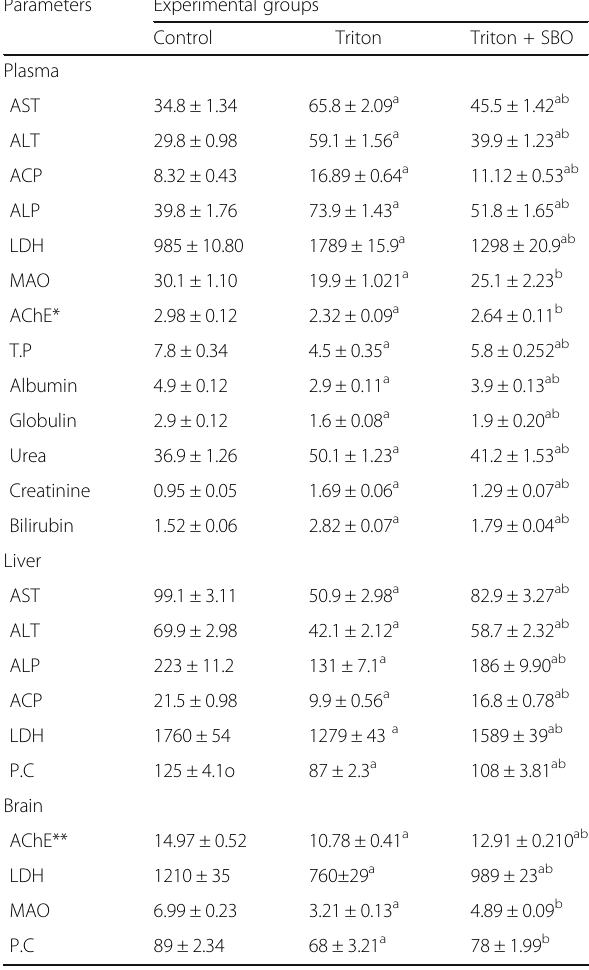
Table 4 The effect of soybean oil (SBO), Triton WR-1339, and their combination on plasma, liver, and brain biochemical parameters in male rats compared to a control group